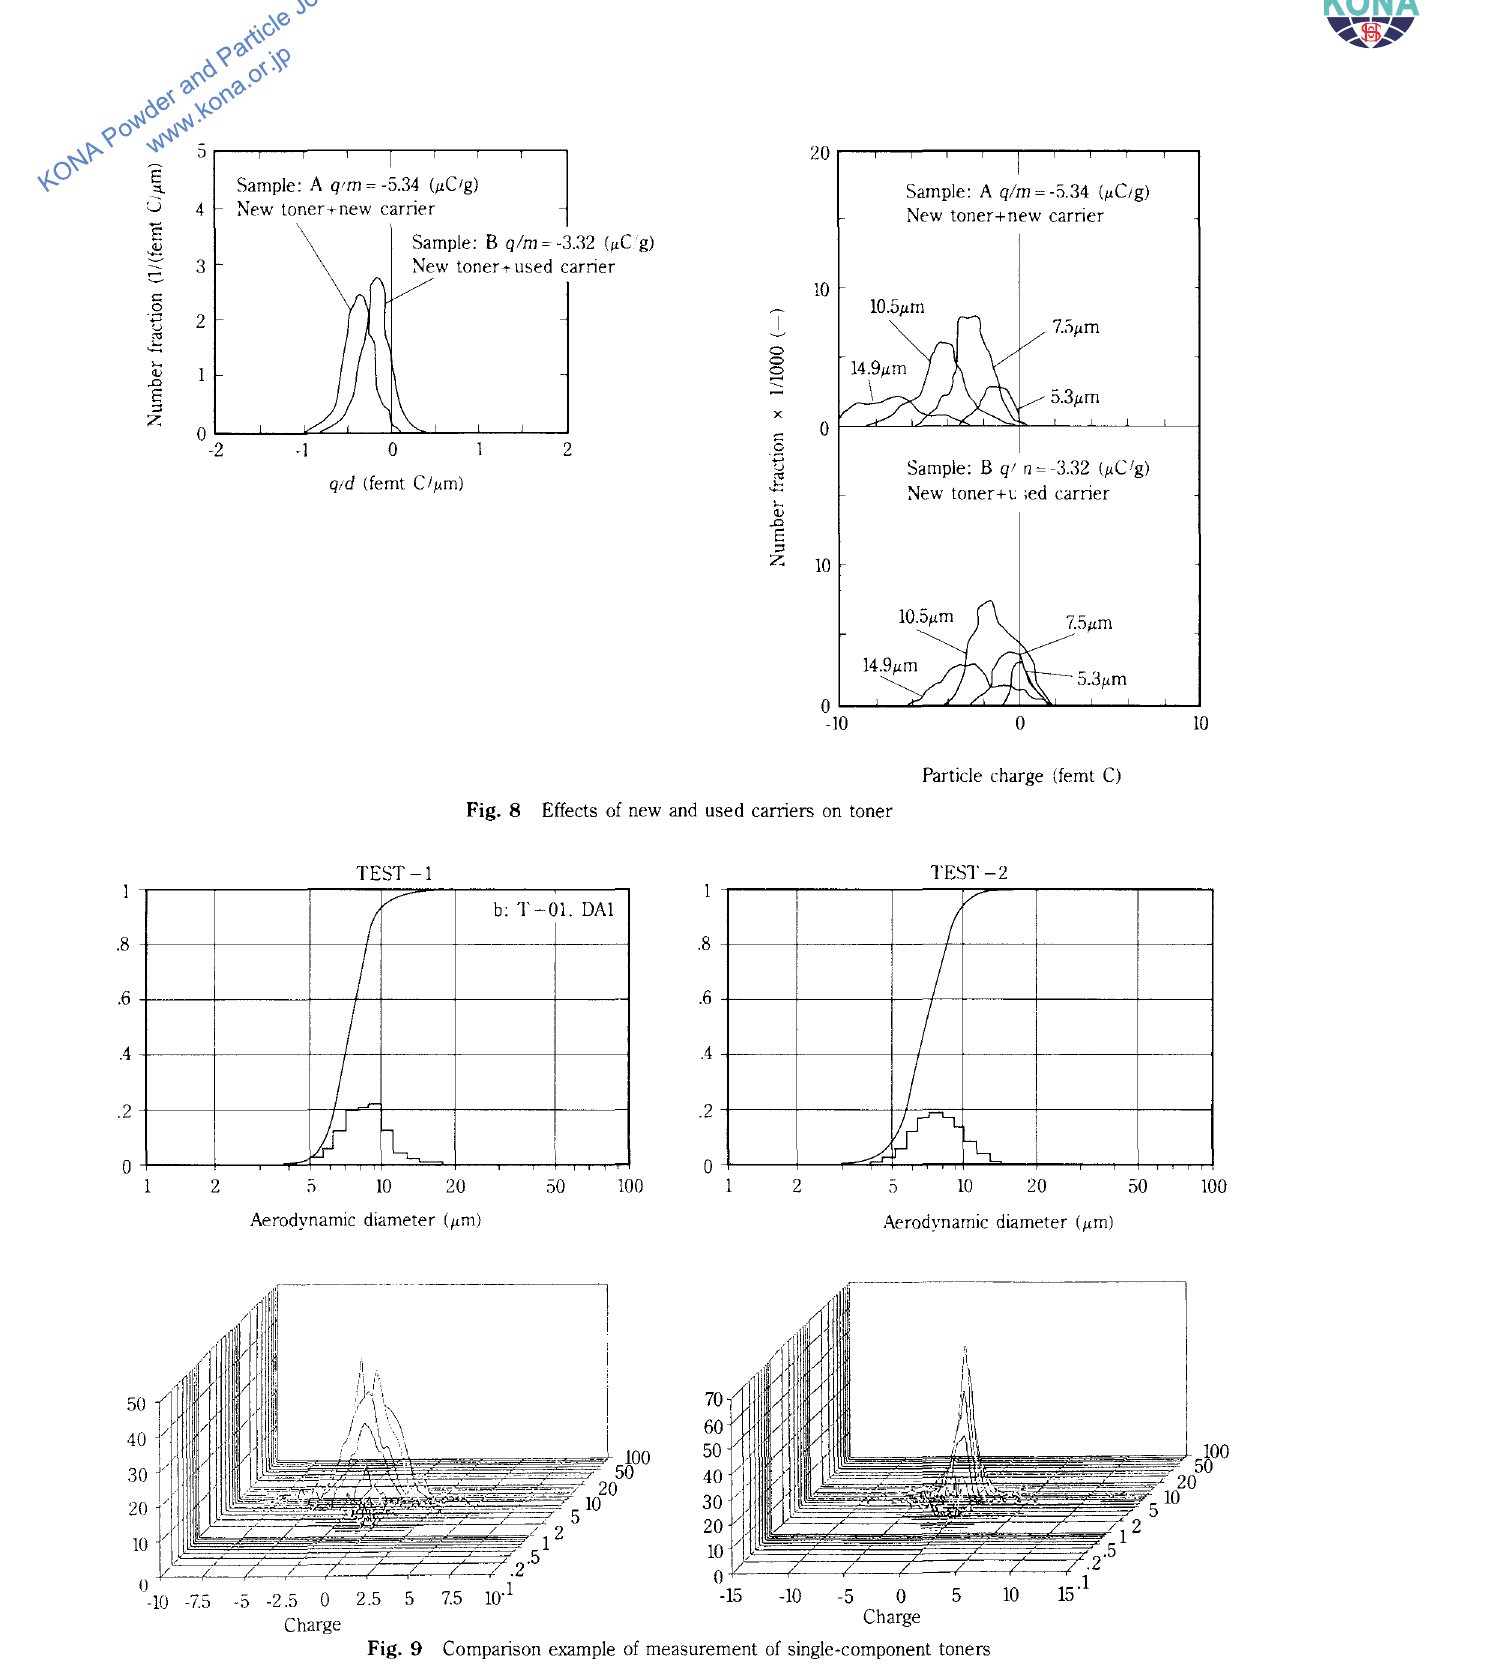
Fig. 9 Comparison example of measurement of single-component